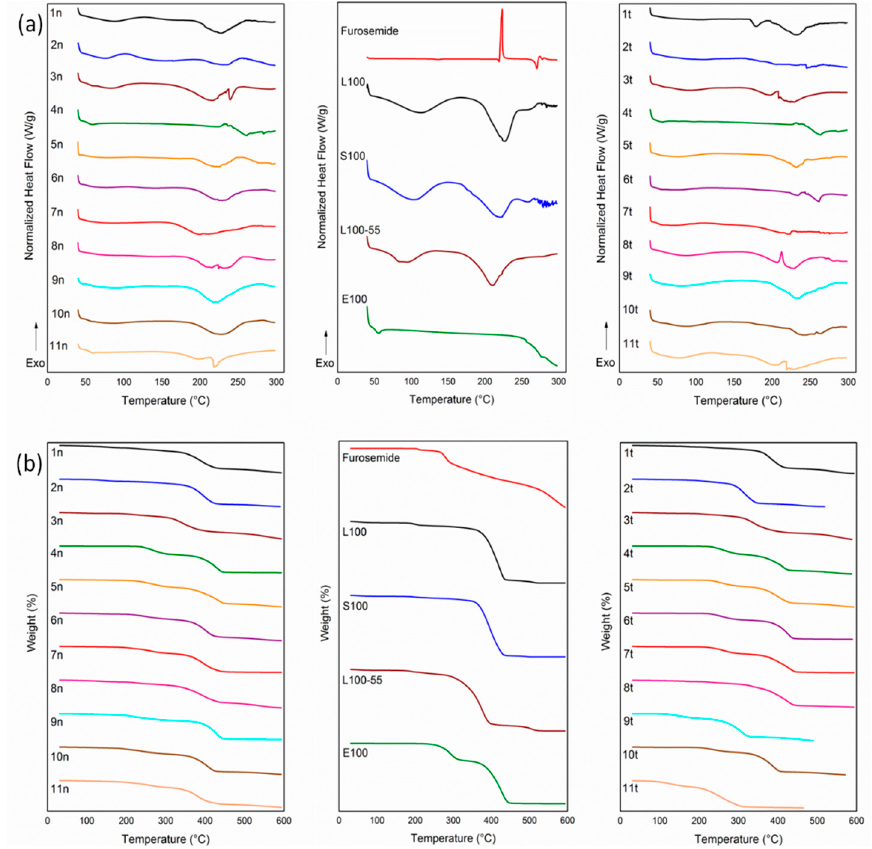
Figure 3. ( a ) DSC and ( b ) TGA thermograms of the raw materials, electrospun nanofibrous mats (formulations 1n–11n) and physical mixture matrix tablets (formulations 1t–11t).